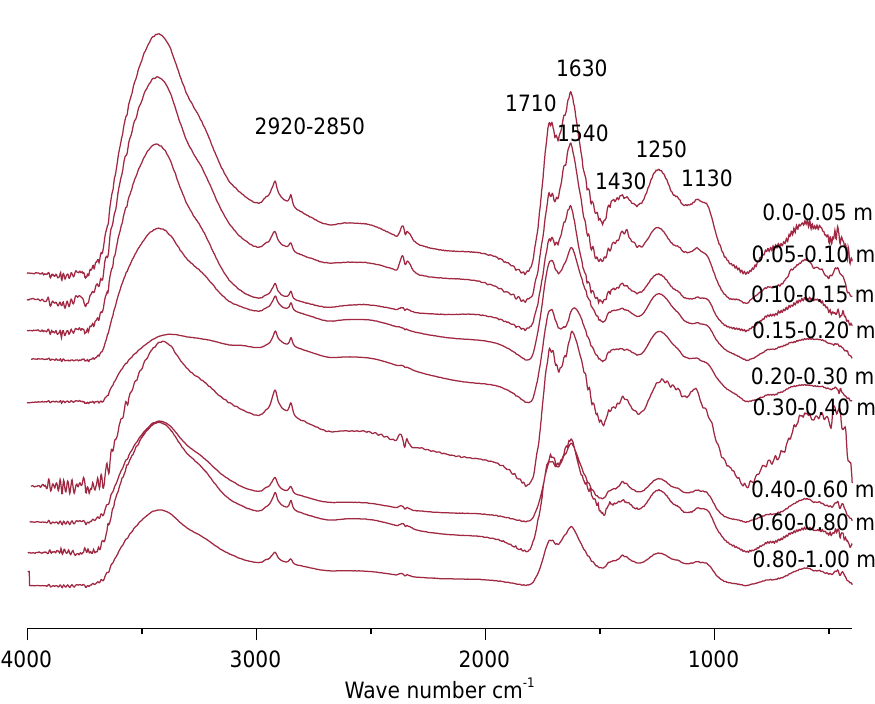
Figure 1. FTIR spectra of soil organic matter after 10 % HF (v/v) treatments of Fluvaquentic Humaquepts under Araucaria moist